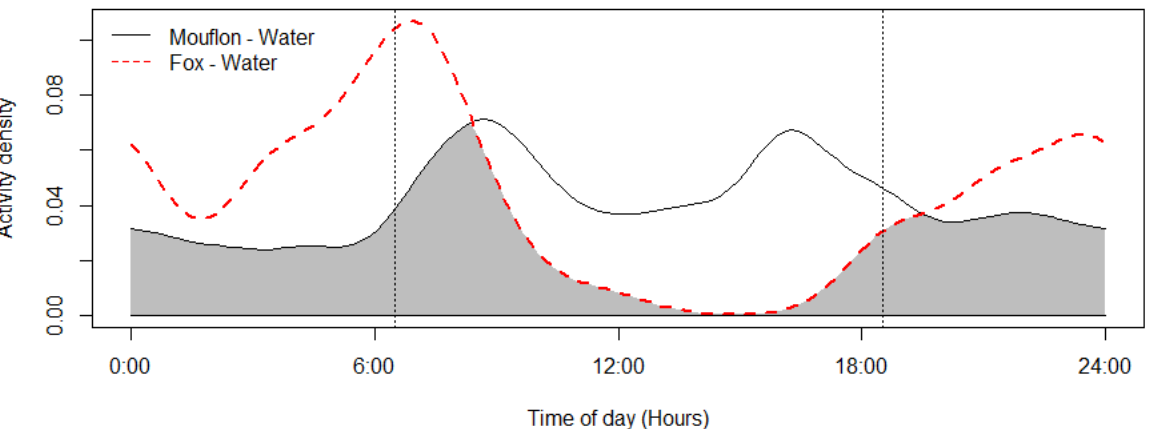
Figure 5. Mouflon and red fox activity overlap at the ten monitored water troughs (coefficient of overlap Δ = 0.6). Sunrise and sunset are marked at their average time for the study period (gray zone shows the overlap area).